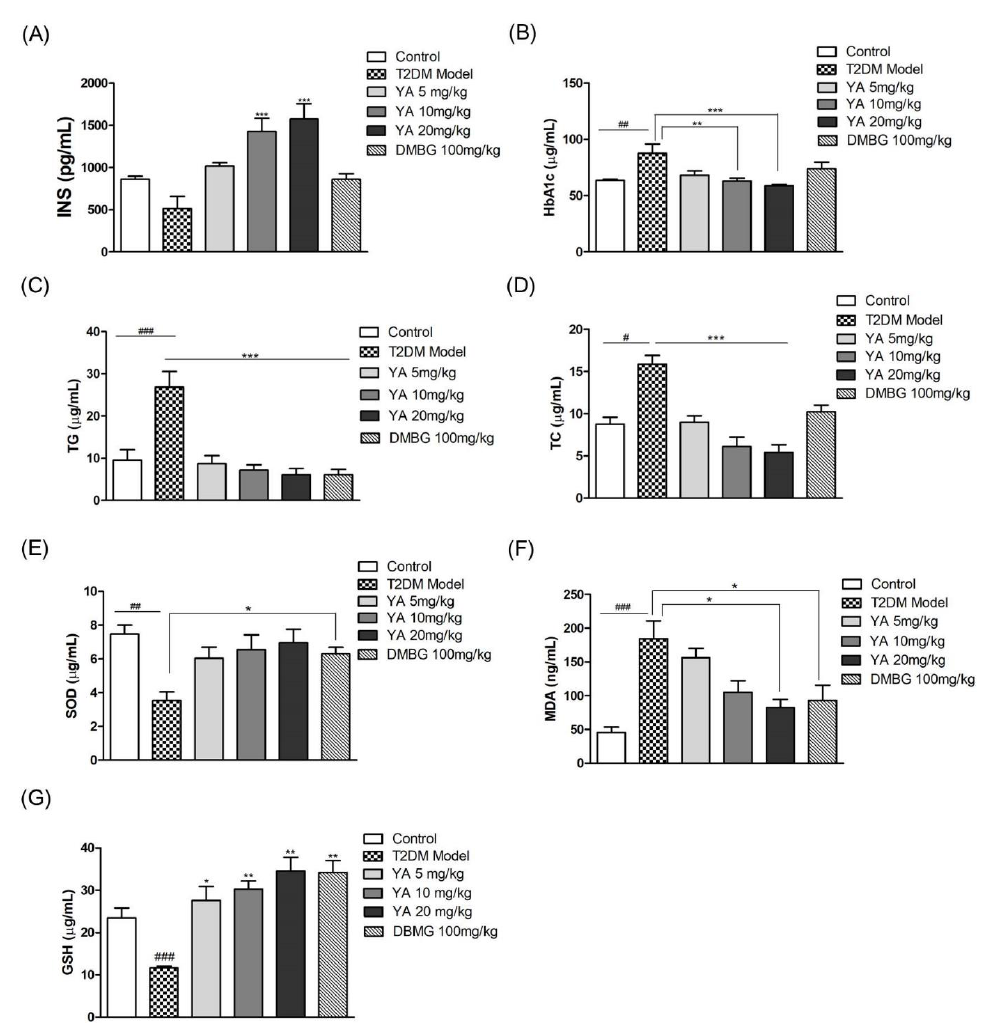
Figure 8. Effect of YA on the levels of insulin, hemoglobin A1C (HbA1c), triglyceride (TG), total cholesterol (TC), and malonaldehyde (MDA), and on the activities of superoxide dismutase (SOD) and glutathione (GSH) in serum. ( A ) insulin; ( B ) HbA1c; ( C ) TG; ( D ) TC; ( E ) SOD; ( F ) MDA; ( G ) GSH. Data are expressed as mean ± SD for each group. ( n = 8; DMBG: metformin) ( # p < 0.05 vs. control, ## p < 0.01 vs. control, ### p < 0.001 vs. control, * p < 0.05 vs. model, ** p < 0.01 vs. model, *** p < 0.001 vs. model).